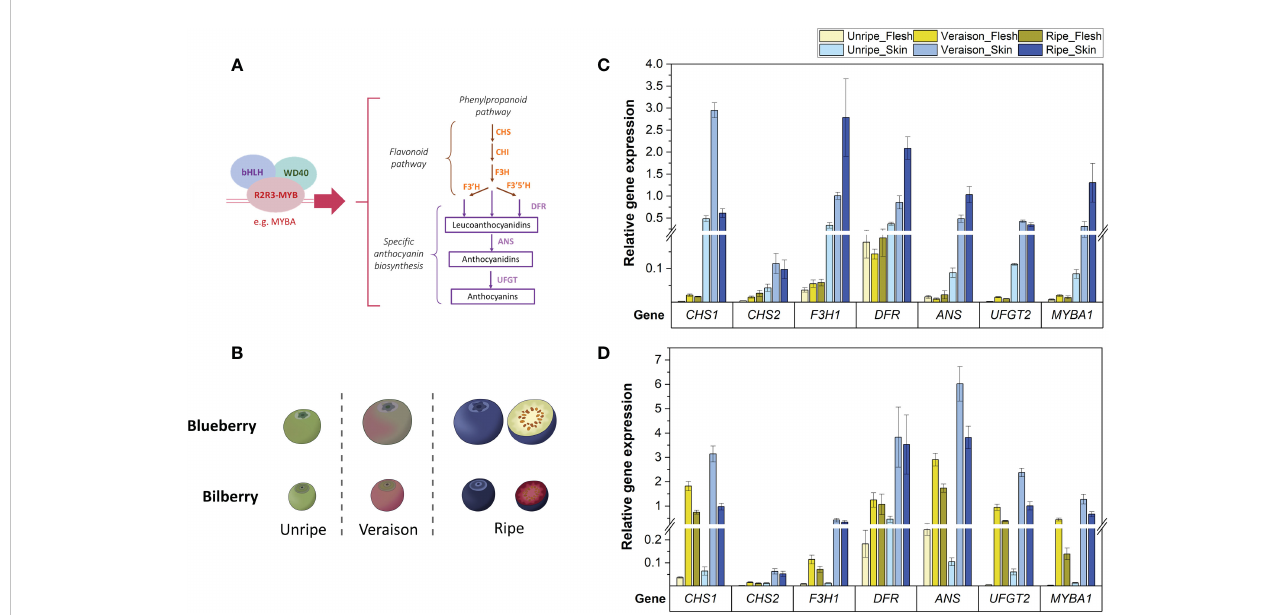
FIGURE 1 (A) The anthocyanin biosynthesis pathway showing structural genes and the MBW complex controlling the pathway. (B) Developmental stages used for RT-qPCR analysis of blueberry and bilberry fruit. Fruit stages unripe-ripe correspond to blueberry stages S5-7 (Zifkin et al., 2012) and bilberry stages S3-5 (Karppinen et al., 2016). (C, D) RT-qPCR analysis of the TF MYBA1 and structural anthocyanin genes in the fl esh and skin of blueberry (C) and bilberry (D) at three fruit developmental stages (unripe, veraison and ripe). Mean relative expression from at least three technical replicates is shown. Error bars represent ± standard